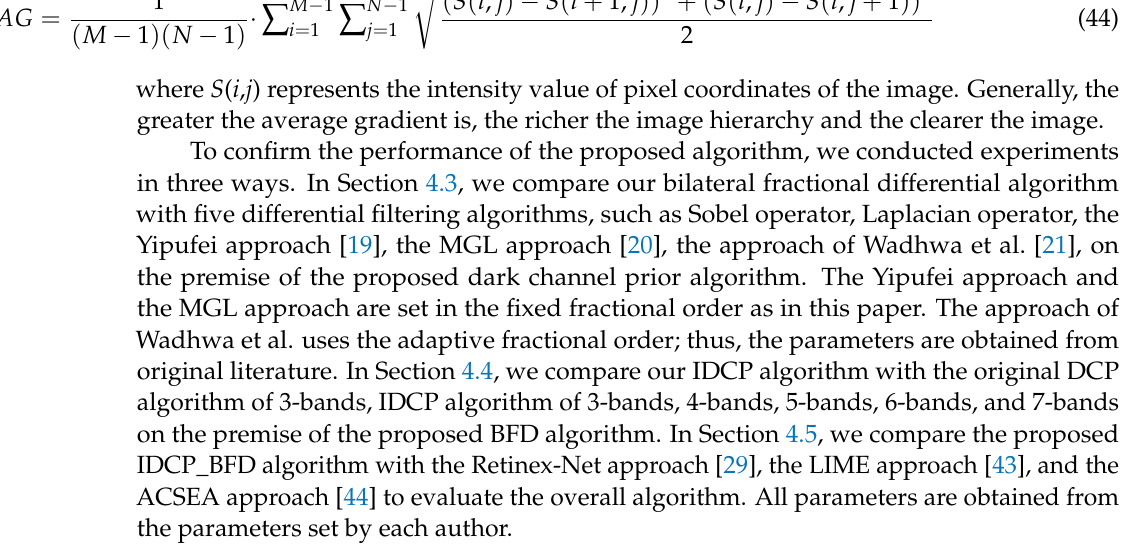
IDCP algorithm of 3-bands, 4-bands, 5-bands, 6-bands, and